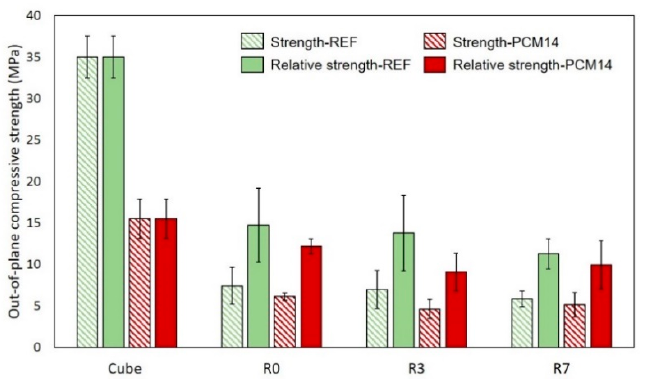
Figure 15. Comparison of the out-of-plane compressive strength between R0, R3 and R7 (measured from H40 specimens) and the material cube strength.